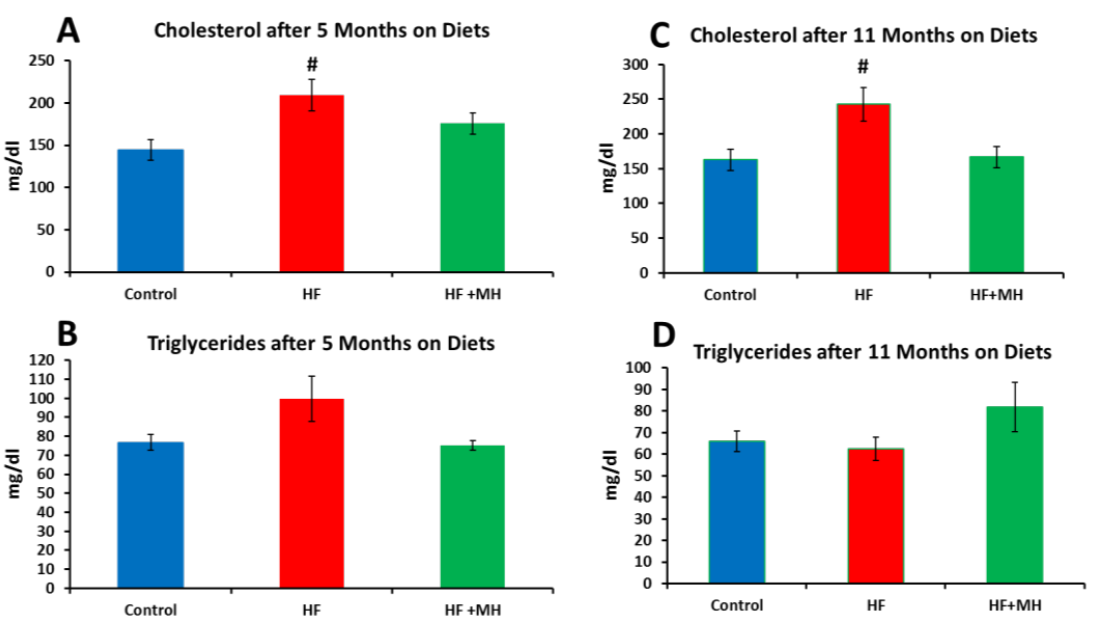
Figure 5. ( A ): Cholesterol measured after 5 months on diets. ( B ): Triglycerides measured after 5 months on diets. ( C ): Cholesterol measured after 11 months on diets. ( D ): Triglycerides measured after 11 months on diets. At 5 months Ns = 5–8. At 11 months Ns = 7–8. # = p < 0.05 compared to controls.